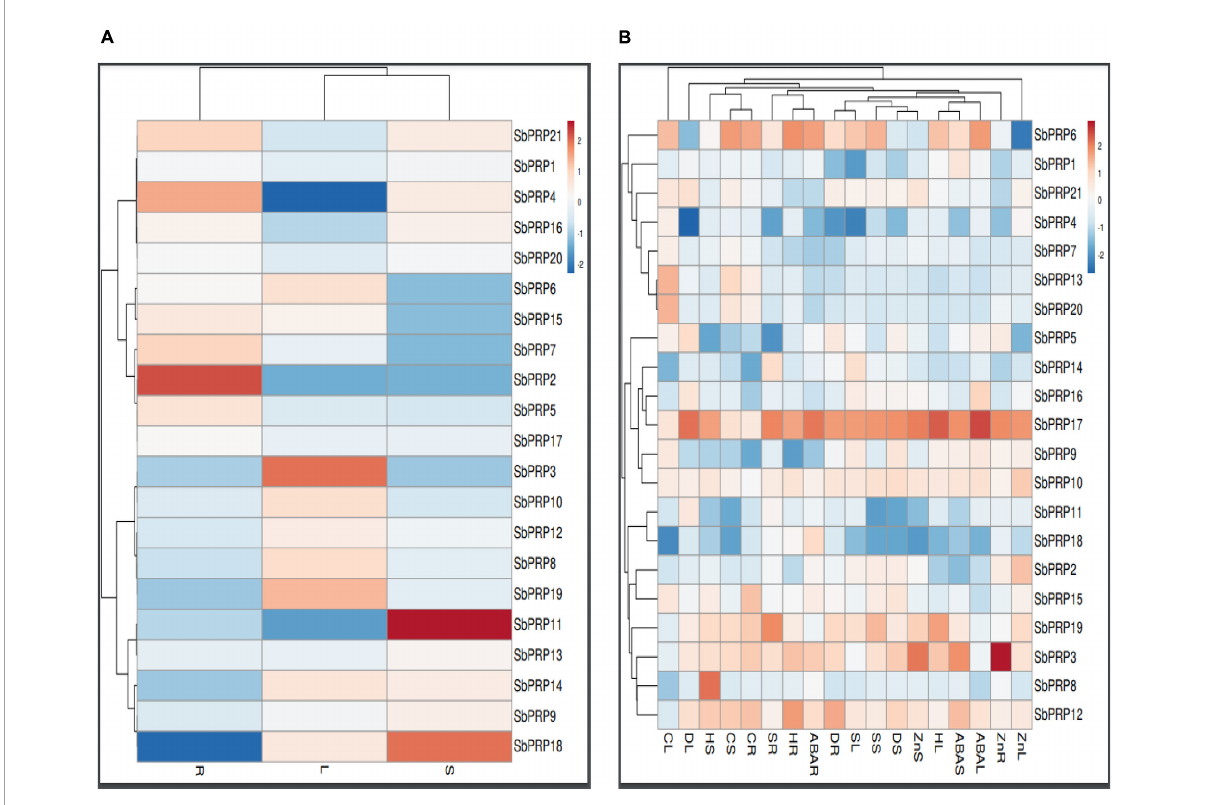
FIGURE8 qRT-PCR expression profiling of SbPRP s. (A) Native expression analysis in root, stem, and leaf, (B) relative expression analysis in root, stem, and leaf under drought, salt, heat, cold, ABA, and Zn stresses. R, root; S, stem; L,